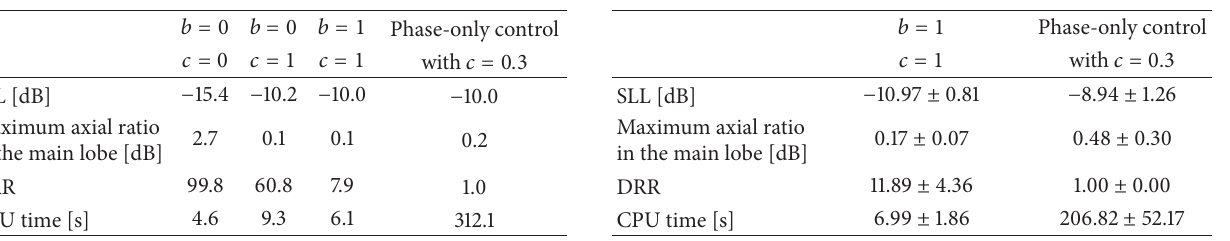
Table 1: Performance of the proposed algorithm. Table 2: Impact of the starting point on the results.